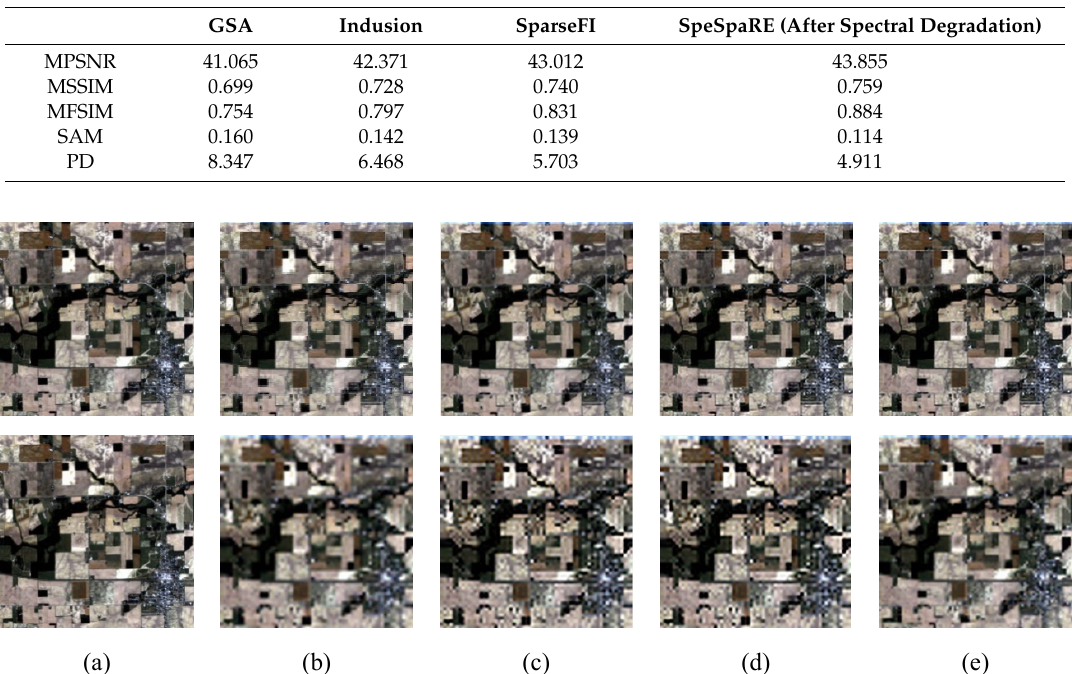
Figure 4. Spatial resolution enhancement comparison on Indian pines dataset, from top to bottom are the comparison with down-sampling factor of 2 and 4. ( a ) Reference HRI, spatial resolution enhancement results of ( b ) GSA method, ( c ) Indusion method, ( d ) SparseFI method and ( e ) Proposed J-SpeSpaRE method (after spectral degradation).